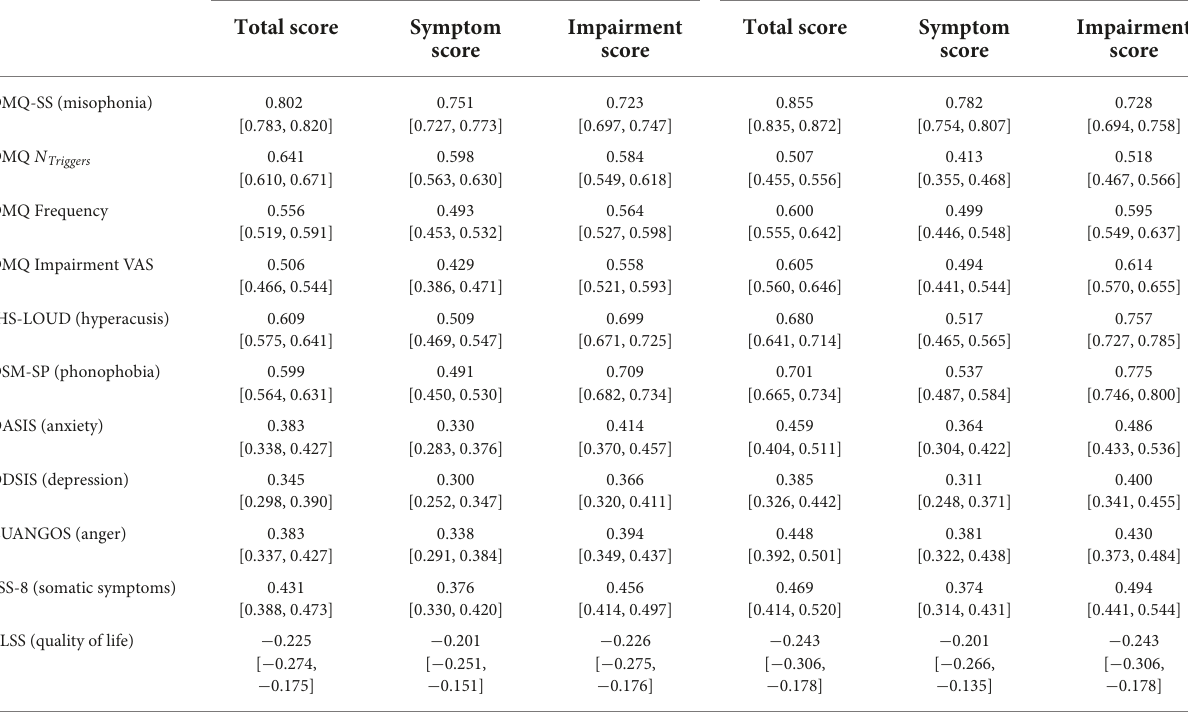
TABLE 7 Pearson correlations between DVMSQ scores and external